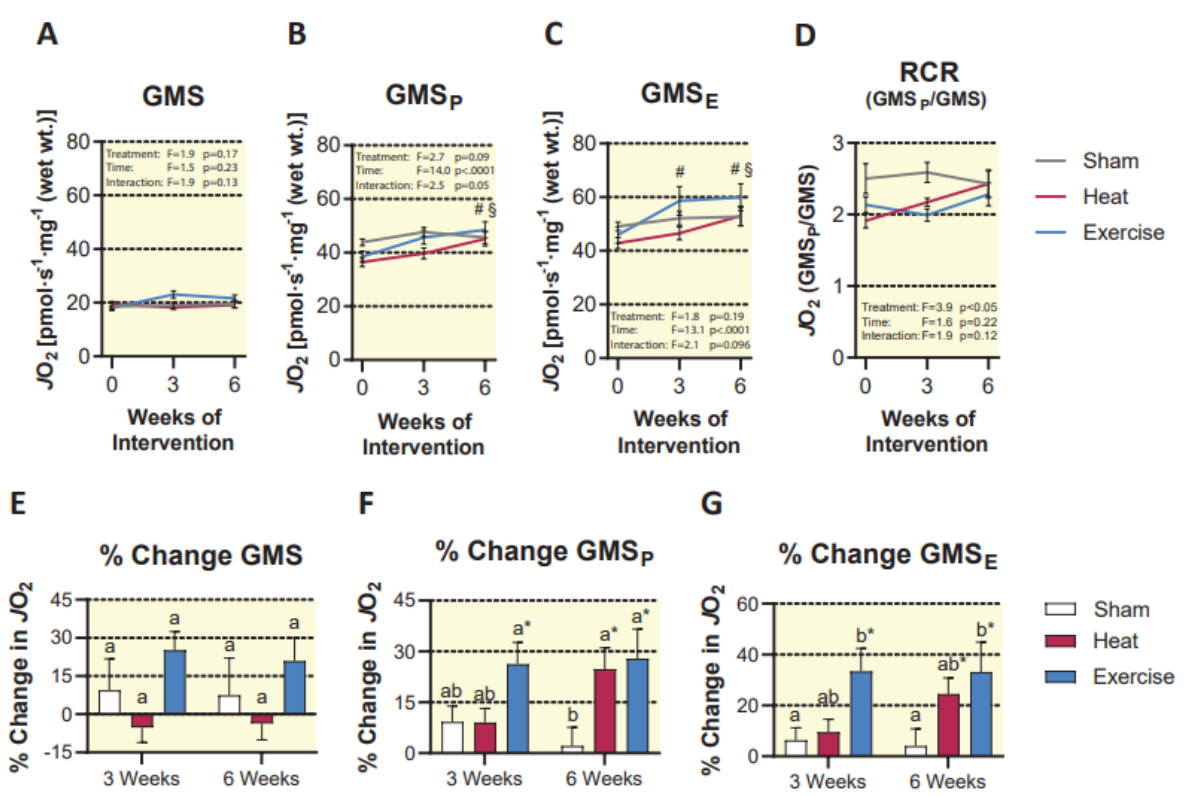
Figure 5. Mitochondrial respiration expressed as absolute respiration over the course of the intervention ( A–C ) and respiratory control ratio ( D ). Respiration expressed as a percent change from baseline in each group ( E-G ). Statistical difference in the HT group compared to baseline is indicated by § ( p < 0.05). Statistical difference in the EX group compared to baseline is indicated by # ( p < 0.05). In panels E-G, shared letters are no different from each other, and an asterisk (*) indicates a significant difference from baseline ( p < 0.05). Results are represented as mean ± SEM ( n = 8–11).